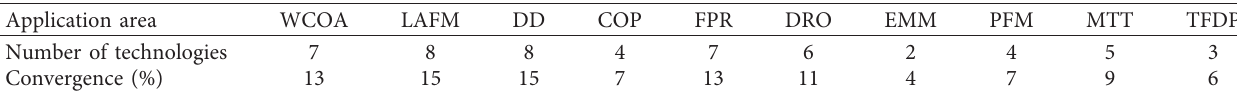
Table 13: Percentage convergence in logistics application